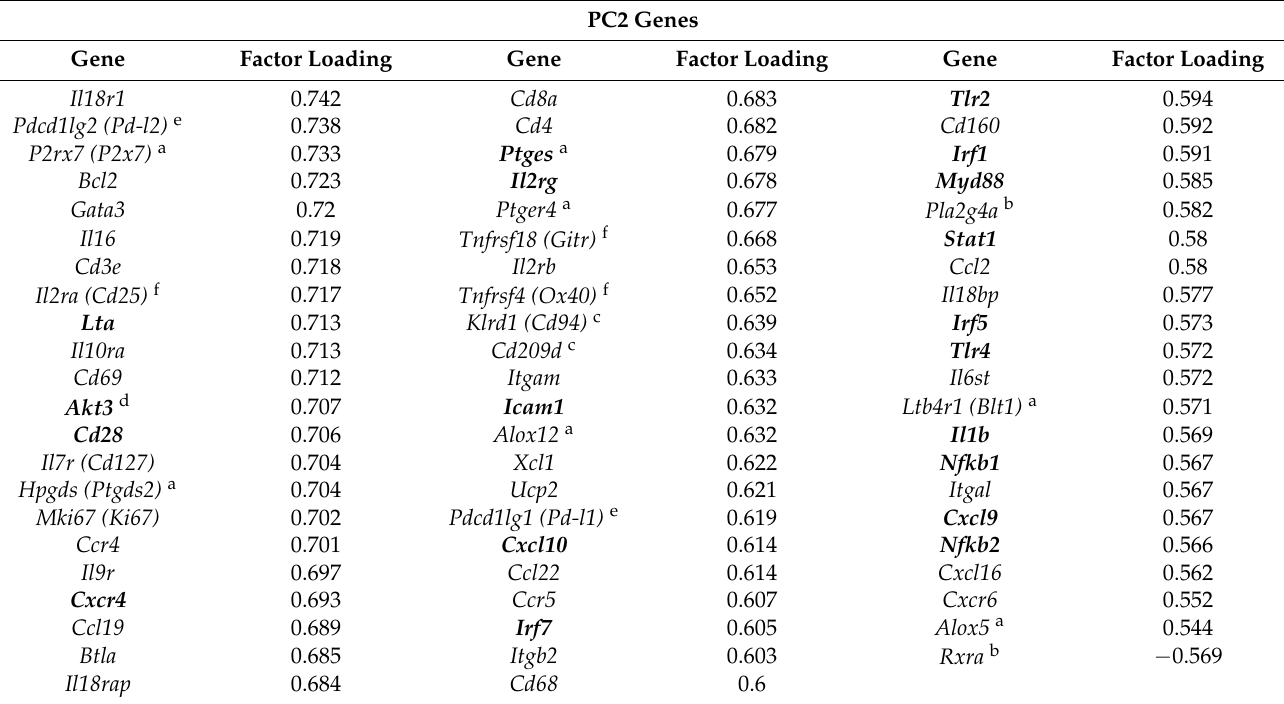
Figure 2. Multivariate analysis identified particular gene expression profiles at one and ten days post infection. qPCR was carried out on liver tissue from control and L. infantum -infected mice and at 1, 3, 5, and 10 days post infection. Principal component analysis (PCA) plot. Principal components scores are shown on the X and Y axis, respectively, with the proportion of total variance related to that principal component (PC) indicated. Each dot represents a mouse in the corresponding day, and the color indicates the condition (red, infected; blue, control). The clouds highlight the group of ten days p.i. mice by PC3 (green cloud) and the group of one day p.i. mice by PC2 (blue cloud). Table 1. Highest factor loadings of PC2 and PC3 from the Principal Component Analysis (PC2/PC3-correlated